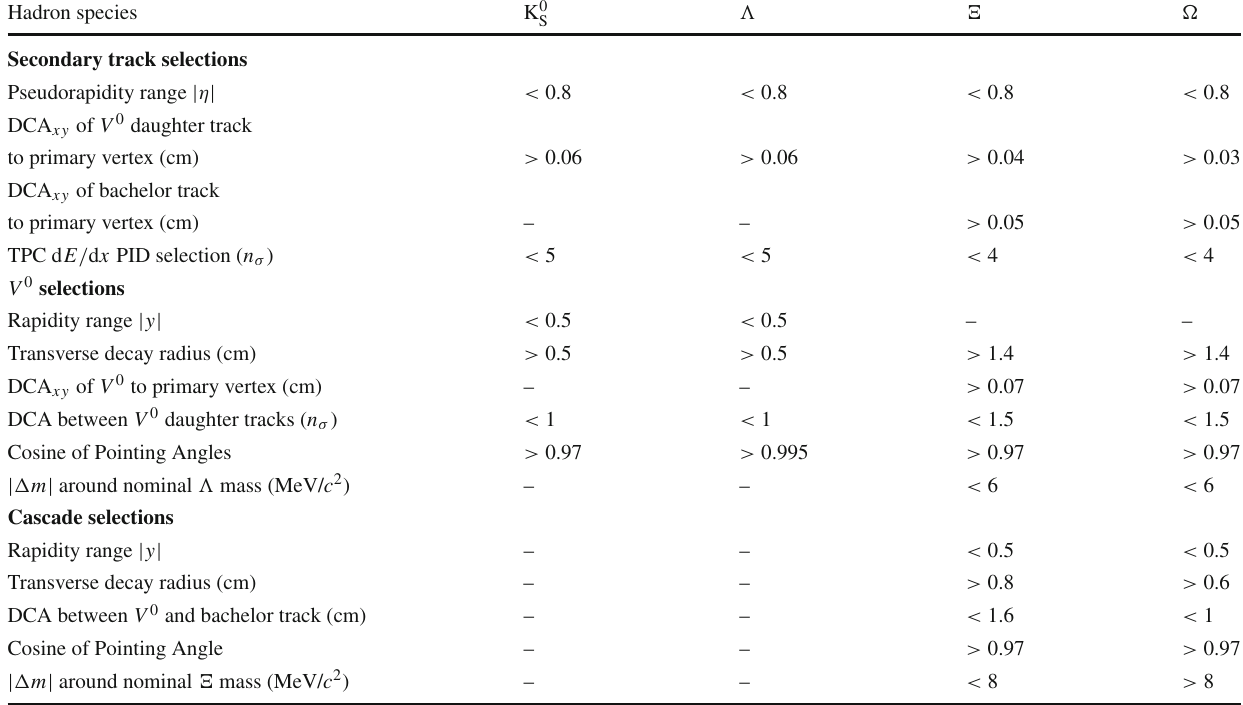
Table 4 Selection criteria for secondary and bachelor tracks as well as for V 0 and cascade candidates applied in the presented work Hadron species K 0